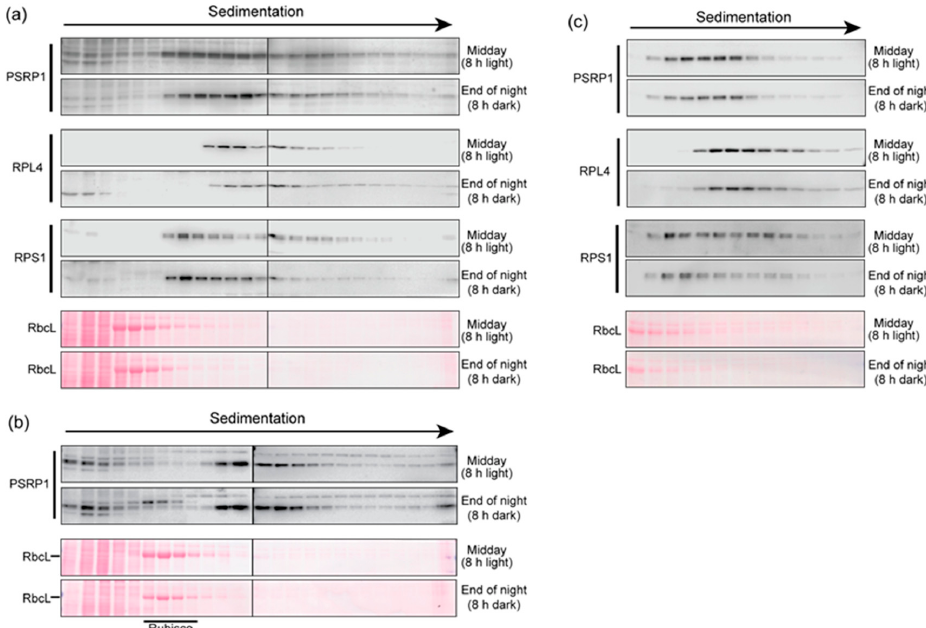
Figure 2. Sucrose gradient sedimentation of extracts of leaves harvested at midday (8 h light) or at the end of the night (8 h dark). The extraction bu ff er contained 10 mM Mg ++ to maintain ribosome integrity, but lacked heparin and chloramphenicol, which are required to maintain polysome integrity (see text for rationale). Immunoblots of gradient fractions were probed to detect PSRP1, RPL4 (marker for the chloroplast 50S ribosomal subunit), or RPS1 (marker for the chloroplast 30S ribosomal subunit). In a revised nomenclature, chloroplast RPS1 and RPL4 are designated bS1c and uL4c, respectively [9]. Excerpts of the Ponceau S-stained blots are shown to illustrate the position of Rubisco in the gradients (illustrated by its RbcL subunit). ( a ) and ( b ) The complete set of fractions from two replicate experiments were divided between two gels (demarcated by a line). The gradient in panel ( a ) was centrifuged for 105 min, whereas the gradient in panel ( b ) was centrifuged for 150 min, resulting in deeper sedimentation of PSRP1 and marker proteins. ( c ) The peak PSRP1 fractions from a third experiment (fractions 6 through 19) are displayed on a single gel. The sedimentation conditions were the same as those used in panel ( a ).